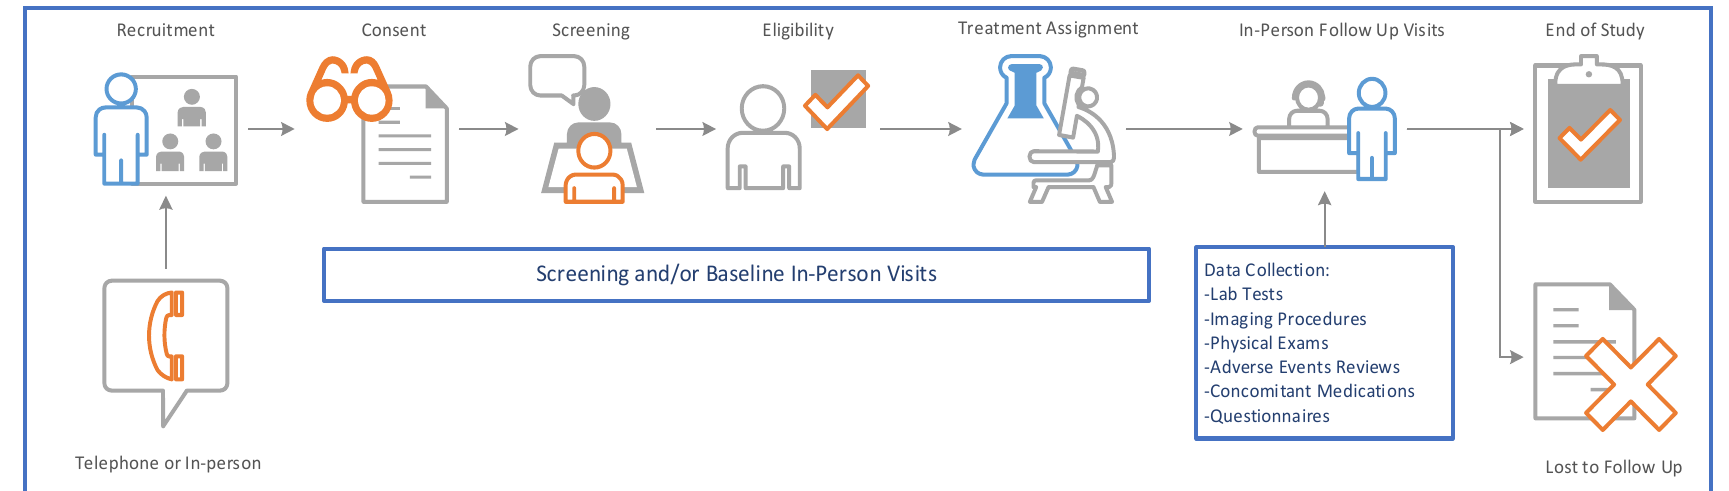
Figure 1: Traditional Randomized Controlled Trial Flow for Participants